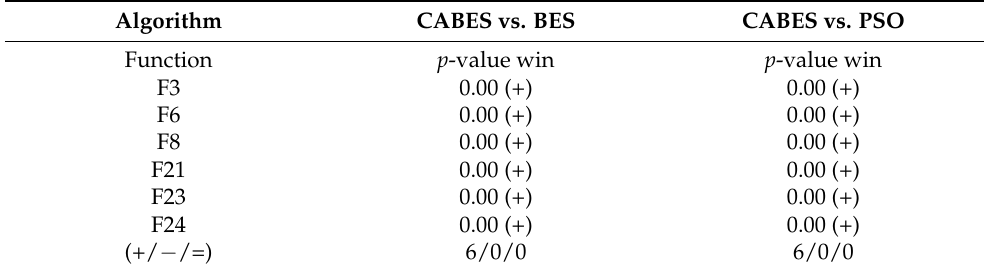
Table 3. p -value for Wilcoxon’s rank-sum test on each algorithm.